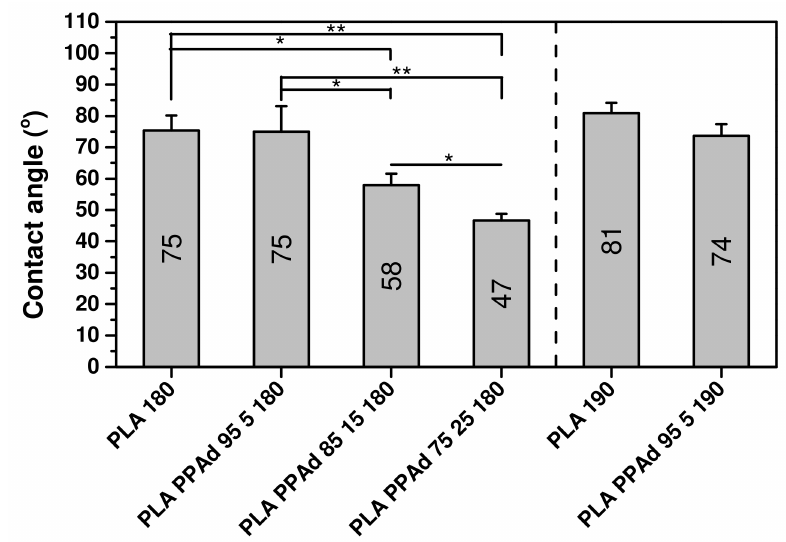
Figure 9. Water contact angle of PLA and the PLA- co -PPAd copolymers. * p < 0.05, ** p <